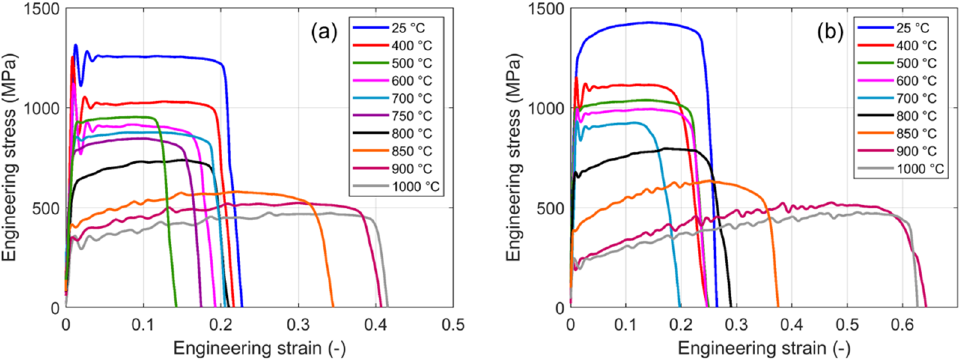
Figure 8. Engineering stress versus engineering strain curves obtained for high strain rate tests per- formed on ( a ) DA and ( b ) HT specimens in the temperature range between 25 °C and 1000 °C. performed on ( a ) DA and ( b ) HT specimens in the temperature range between 25 ◦ C and 1000 ◦